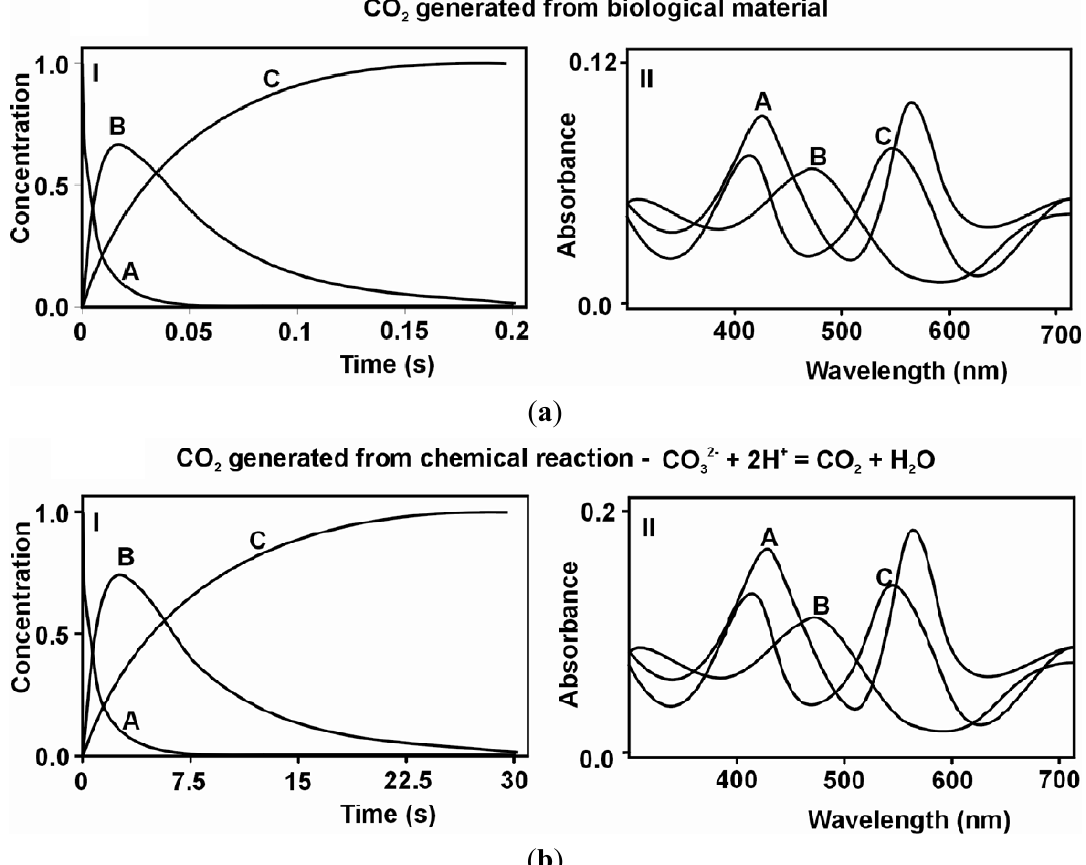
Figure 1. Comparison of the biological and chemical reaction models. ( a ) The biological reaction model (I) Curves of concentration decay and buildup of the substrate A (which is the cis -[Cr(C O )(pm)(OH ) ] + ion), product C as cis- [Cr(C 2 4 2 2 intermediate product B. (II) Absorption spectra of the reactants A, B and C - the detection of CO generated during glutamate induced oxidative stress in HT22 cells. ( b ) The 2 chemical reaction model (I) Curves of concentration decay and buildup of the substrate A (which is the cis -[Cr(C O )(pm)(OH ) ] + ion), product C as cis -[Cr(C 2 4 2 2 ion, and intermediate product B. (II) Absorption spectra of the reactants A, B and C at pH = 7.13, t = 20